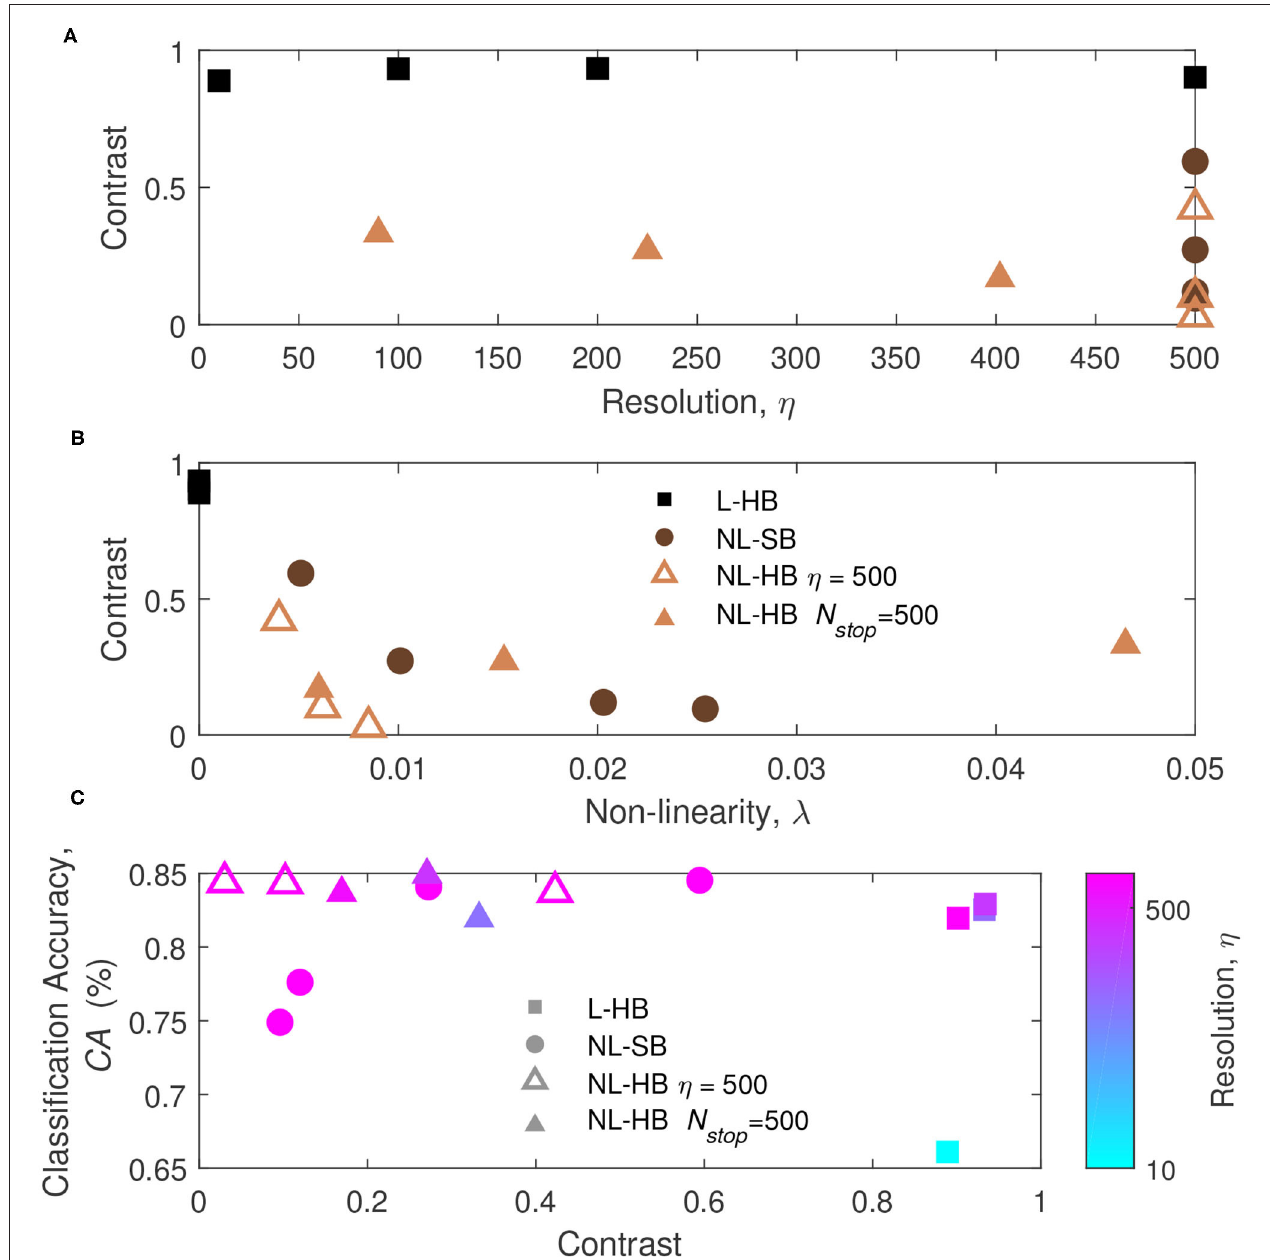
FIGURE 6 | (A,B) Weight contrast at the end of the training as a function of the parameters η and λ , for the L-HB, NL-SB, and NL-HB cases. (C) Classification accuracy, CA , as a function of the weight contrast. The symbols color follow the resolution value, η , according to the color bar reported on the right side of